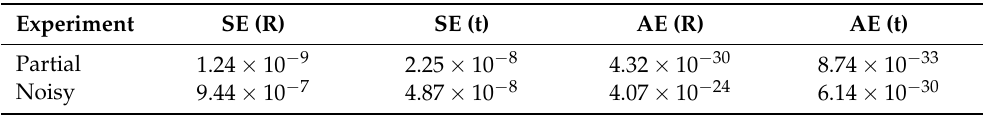
Table 4. The p -value of squared error and absolute error for rotation and translation. The first row presents the results for partial-to-partial registration, while the second row presents the registration results for point clouds with Gaussian